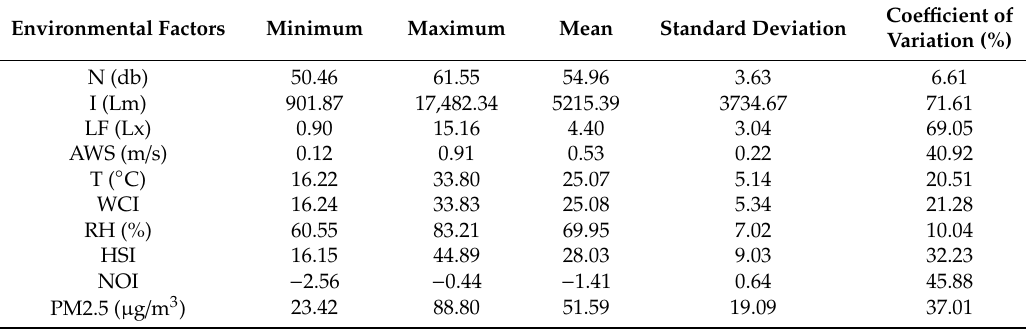
Table 1. Descriptive statistics for the environmental factors in the sample plots.